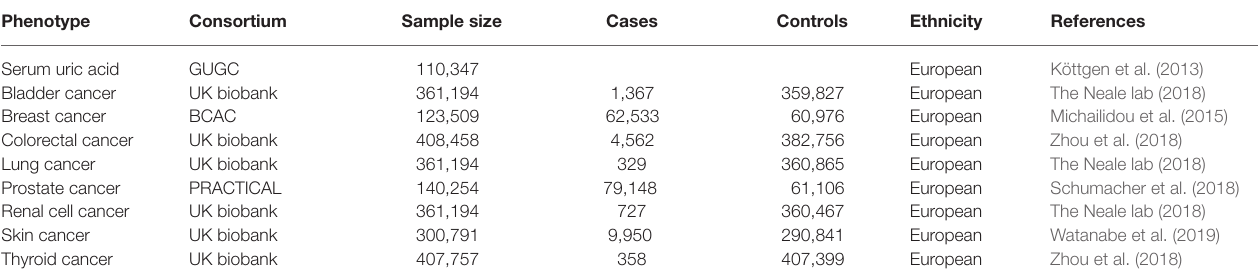
TABLE 1 | Characteristics of exposure dataset and outcome